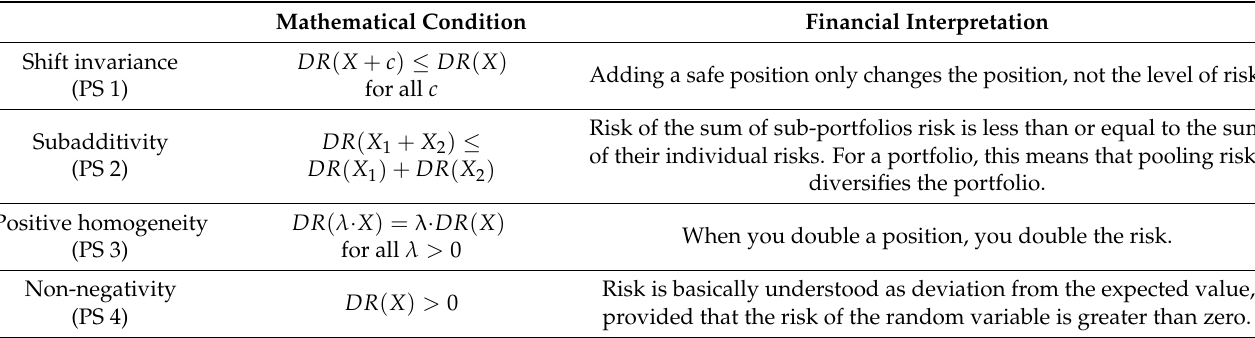
Table 3. Pedersen and Satchell axiom system.